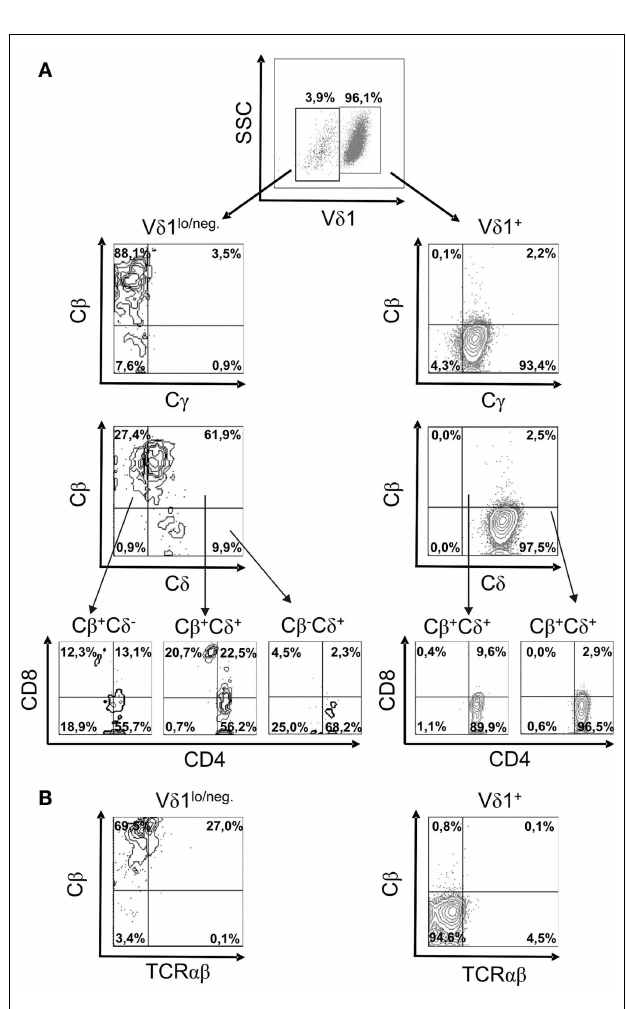
FIGURE 6 | Characterization of the subsets of a CD4 + V δ 1 + clone cells that changesTCR- γδ intoTCR- αβ . (A) V δ 1 + andV δ 1 lo/neg. subpopulation of CD4 + V δ 1 + T-cell clones examined for the expression of C γ , C δ , C β , and C α (as aTCR- αβ framework epitope) as well as co-receptors. A clone representative of seven analyzed clones is shown. (B) TCR- αβ + cells inV δ 1 hi andV δ 1 lo/neg. C β + -expressingV δ 1 + CD4 + T-cell clone fractions. A clone representative of seven analyzed clones is